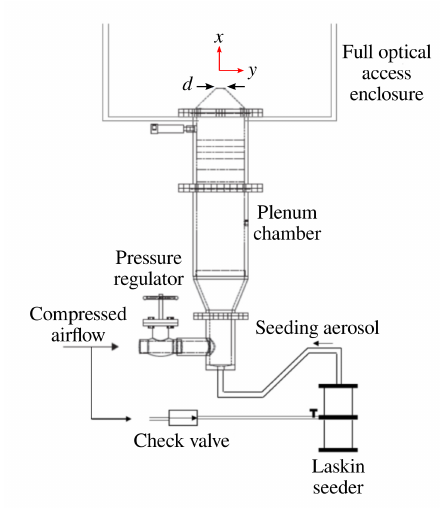
Figure 1. Schematic of the jet